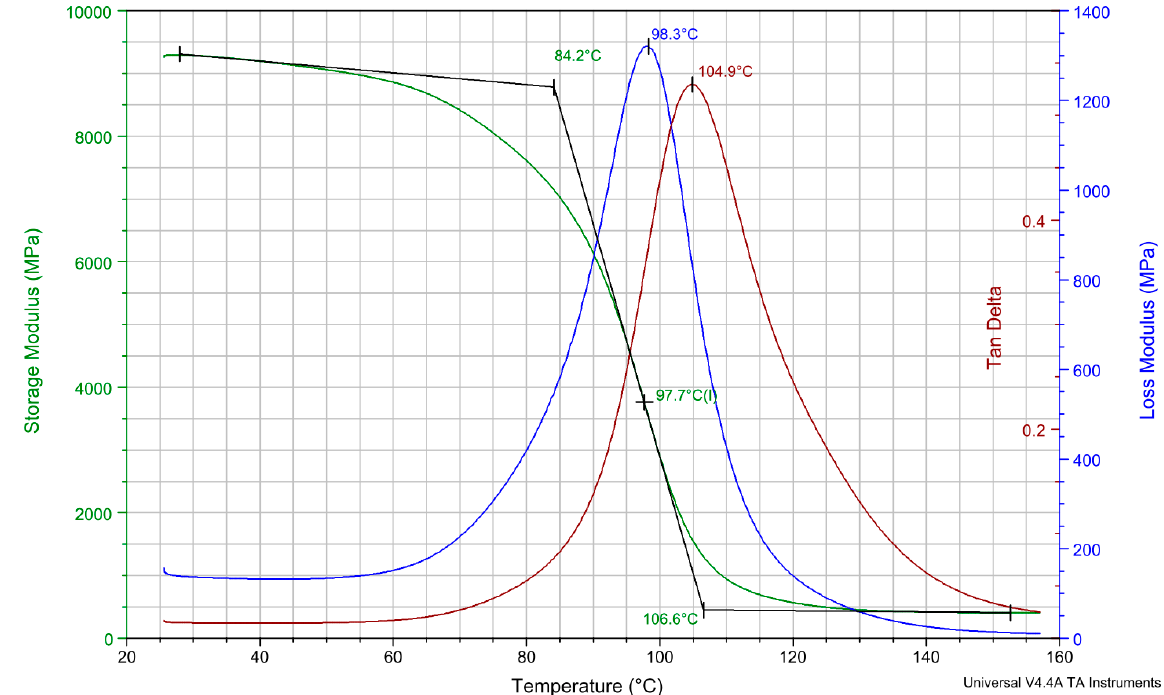
molecular morphology, as a result of which the softening may not occur as the tempera- T ) is mainly defined for crystalline polymers, which ture increases. The melting point ( m may be significantly higher than the glass transition temperature, i.e., . Further- T and T are defined since they also have more, for semi-crystalline polymers, both m g amorphous chains in their structures (e.g., polyetheretherketone (PEEK) and polyphe- nylene sulfide (PPS)). It is worth mentioning that the ratio of for semi-crystalline polymers varies from 0.5 up to 0.75 depending on the degree of crystallinity, so a polymer Figure 10. The exemplary DMA test results for the GFRP specimen. Figure 10. The exemplary DMA test results for the GFRP specimen. with a higher level of crystallinity reveals a lower value [55]. From the microstructural point of view, polymers may reveal amorphous, crystalline or semi-crystalline behavior. The glass transition region mainly appears in an amorphous polymer exposed to heat wherein a viscous, liquid or rubbery state may occur (see Figure 11). This can be explained by how such polymers possess random molecular structures. As a result of an increase in temperature, such amorphous polymers soften gently (e.g., polymethyl methacrylate (PMMM)). Crystalline polymers have a highly ordered